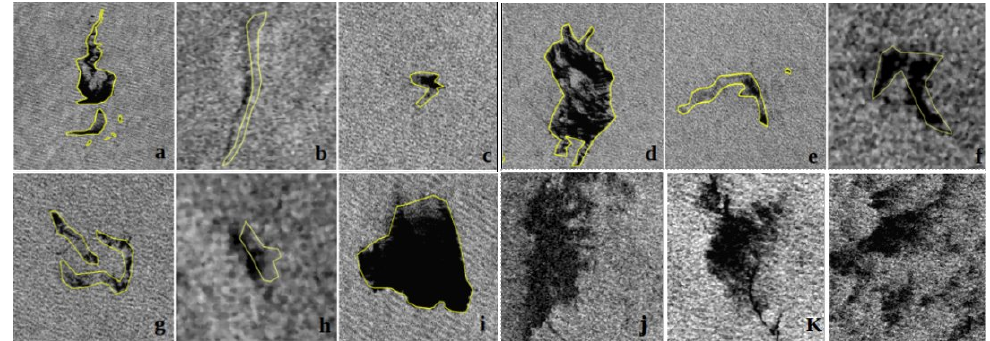
Figure 2. Examples of oil slicks marked in yellow polygons ( a – i ) and lookalike phenomena ( j – l ) extracted from Sentinel-1